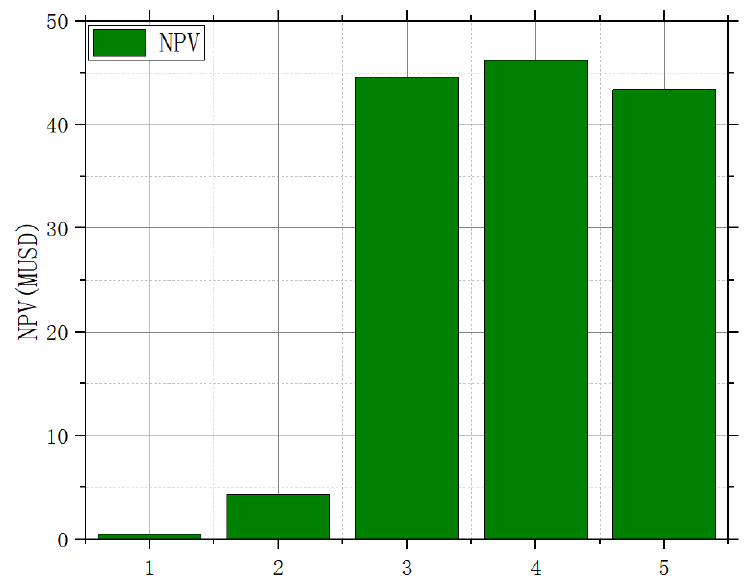
Figure 10. NPV and initial investment cost of five scenarios.